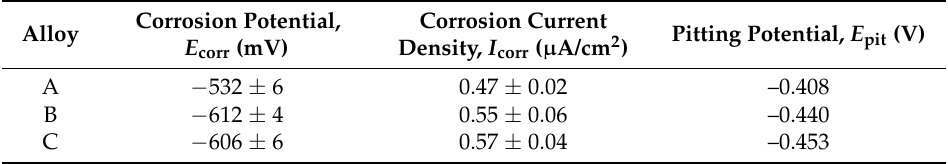
Figure 7. Polarization curves of the peak-aged Al-Mg-Si alloys with different Si contents tested in IGC solution. SCE: saturated calomel electrode. Table 4. E corr and I corr values of the three alloys from the polarization curves determined by the Tafel extrapolation method.